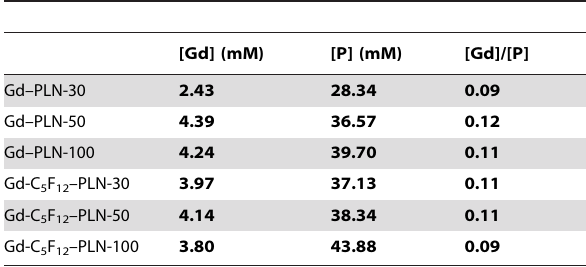
Table 1. Chemical analysis of the synthesized phospholipid nanoparticles.